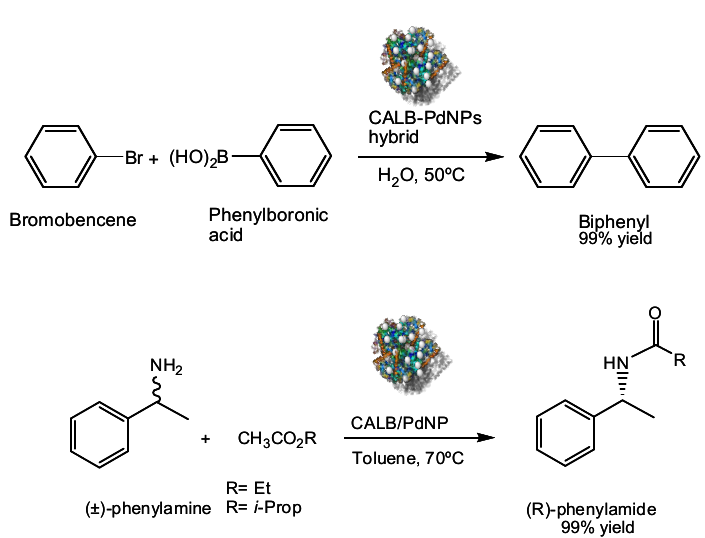
Figure 16. Catalytic applications of CAL-B-PdNPs